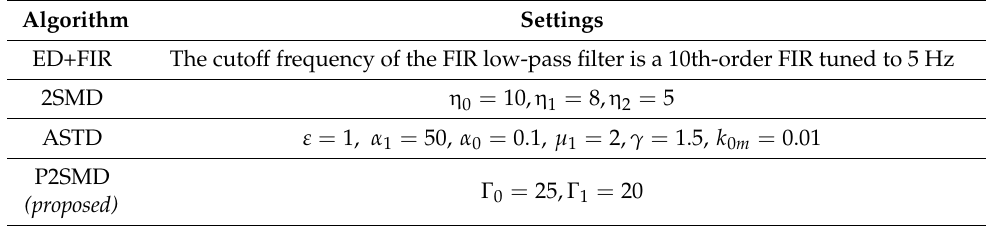
Table 1. Parametric tuning of